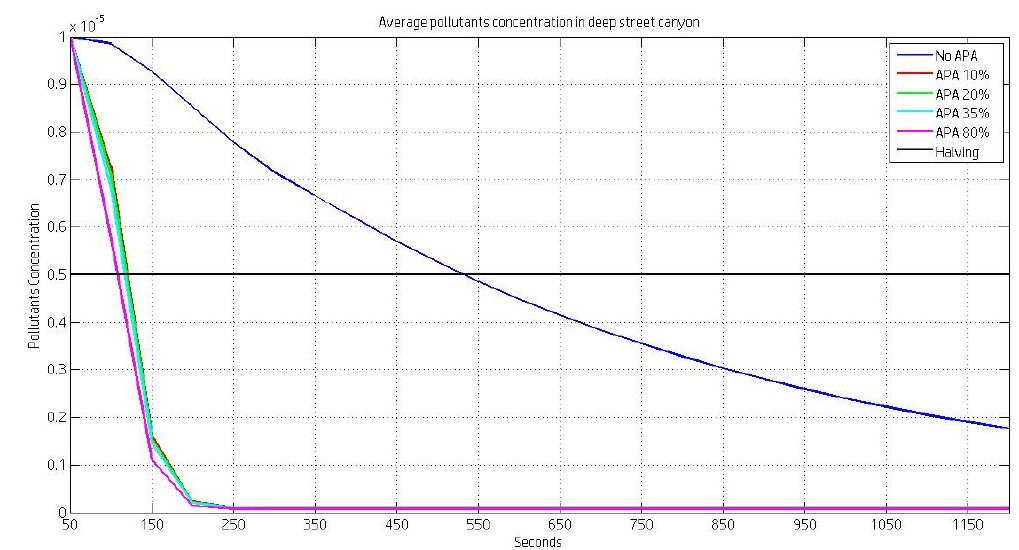
Figure 14. Time series of the average concentration of the passive tracer in a deep street canyon with aspect ratio H/W = 3 without (blue line) and with (colour lines) the APA absorber. Different APA abatement efficiencies are analyzed. The black line denotes half of the initial concentration value used to calculate the canyon cleansing time.